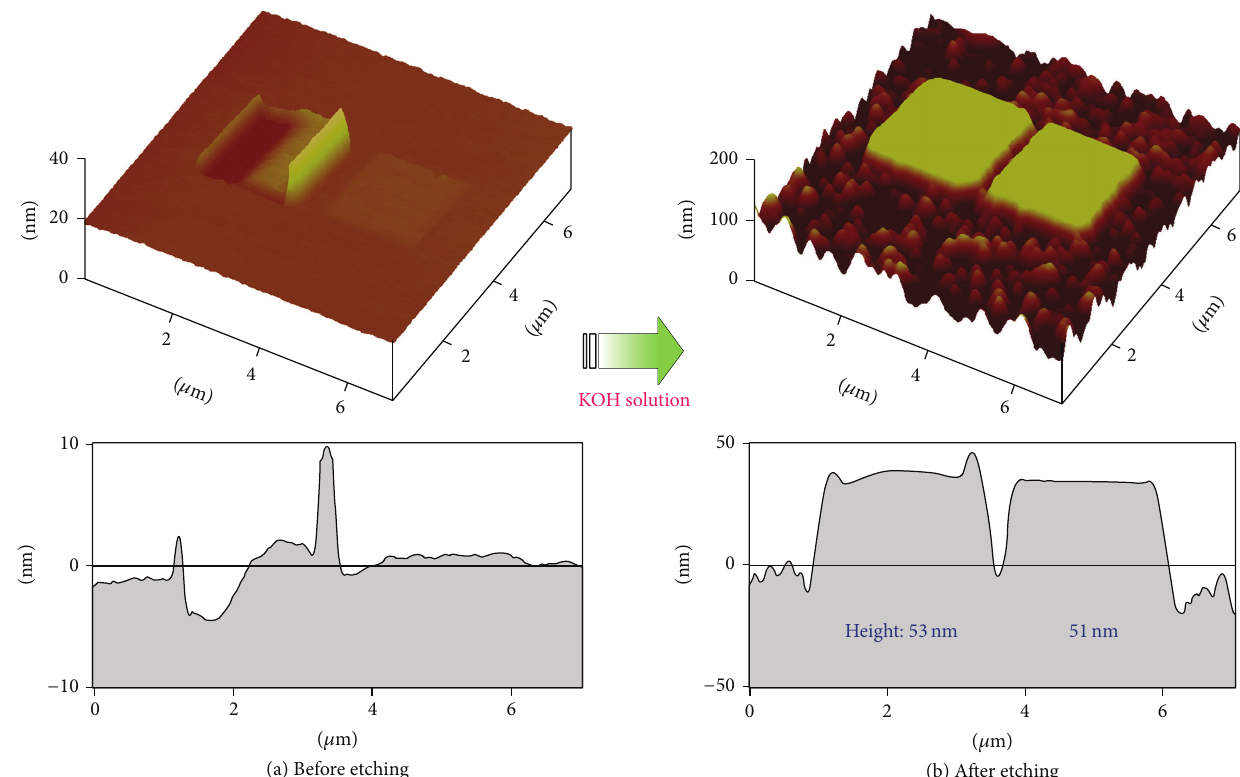
Figure 12: AFM profiles of groove and protuberance processing areas (a) before and (b) after KOH solution etching.